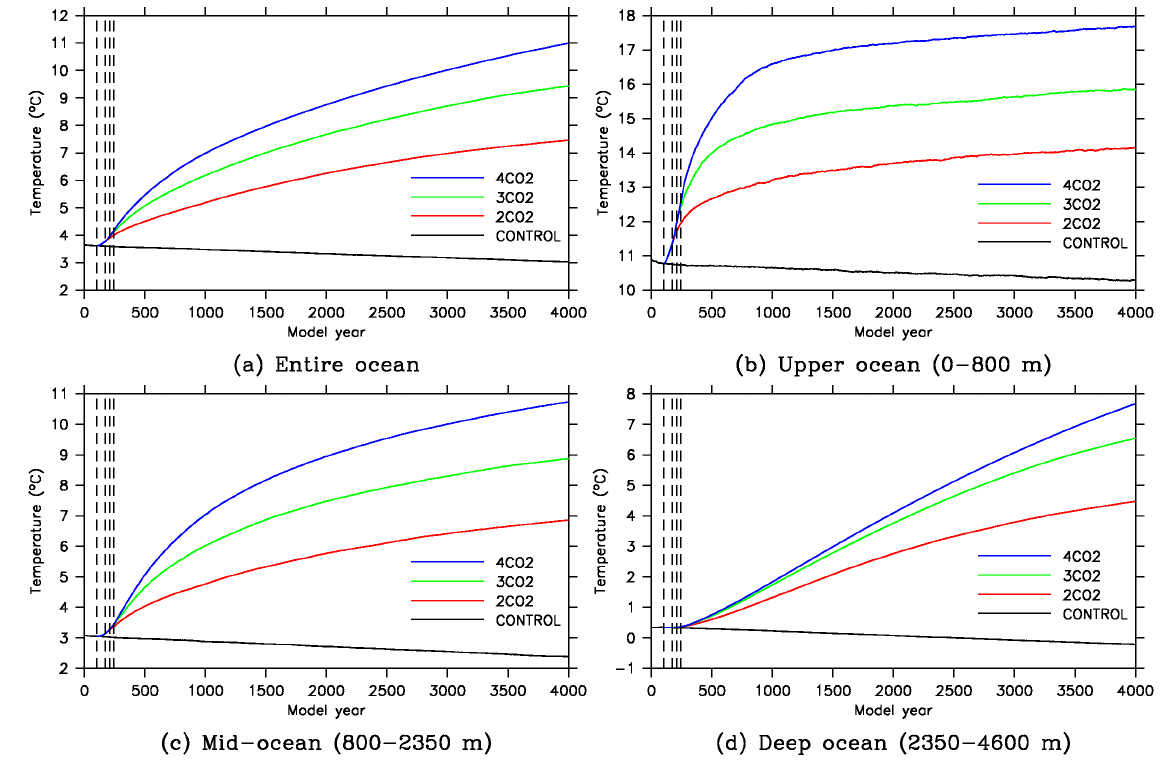
Fig. 22. The change in annual-mean potential temperature during experiments CONTROL (black), 2CO2 (red), 3CO2 (green) and 4CO2 (blue): (a) the entire ocean, (b) the upper ocean (0–800m), (c) the mid-ocean (800–2350m), and (d) the deep ocean (2350–4600m). The values shown are five-year running means and vertical dashed lines indicate model years 100, 170, 211 and